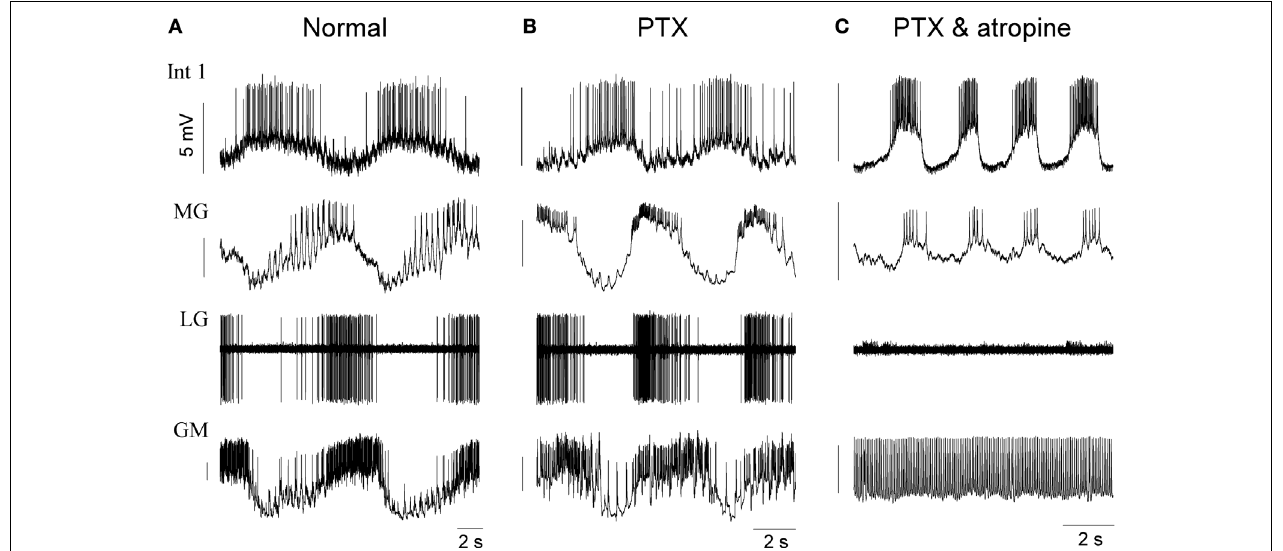
FIGURE 2 | Pharmacological block of synapses by picrotoxin (PTX) and atropine reveals strong intrinsic bursting properties in the Int 1 neuron. (A) Control fi ring pattern of four neurons of the gastric network. (B) Shows the fi ring pattern after blocking the glutamatergic synapses by 10 µM picrotoxin and (C) shows the effects of adding 2 mM atropine to block both glutamatergic and cholinergic synapses. While PTX has a relatively weak effect on the overall pattern, the fi ring, especially in the MG becomes more